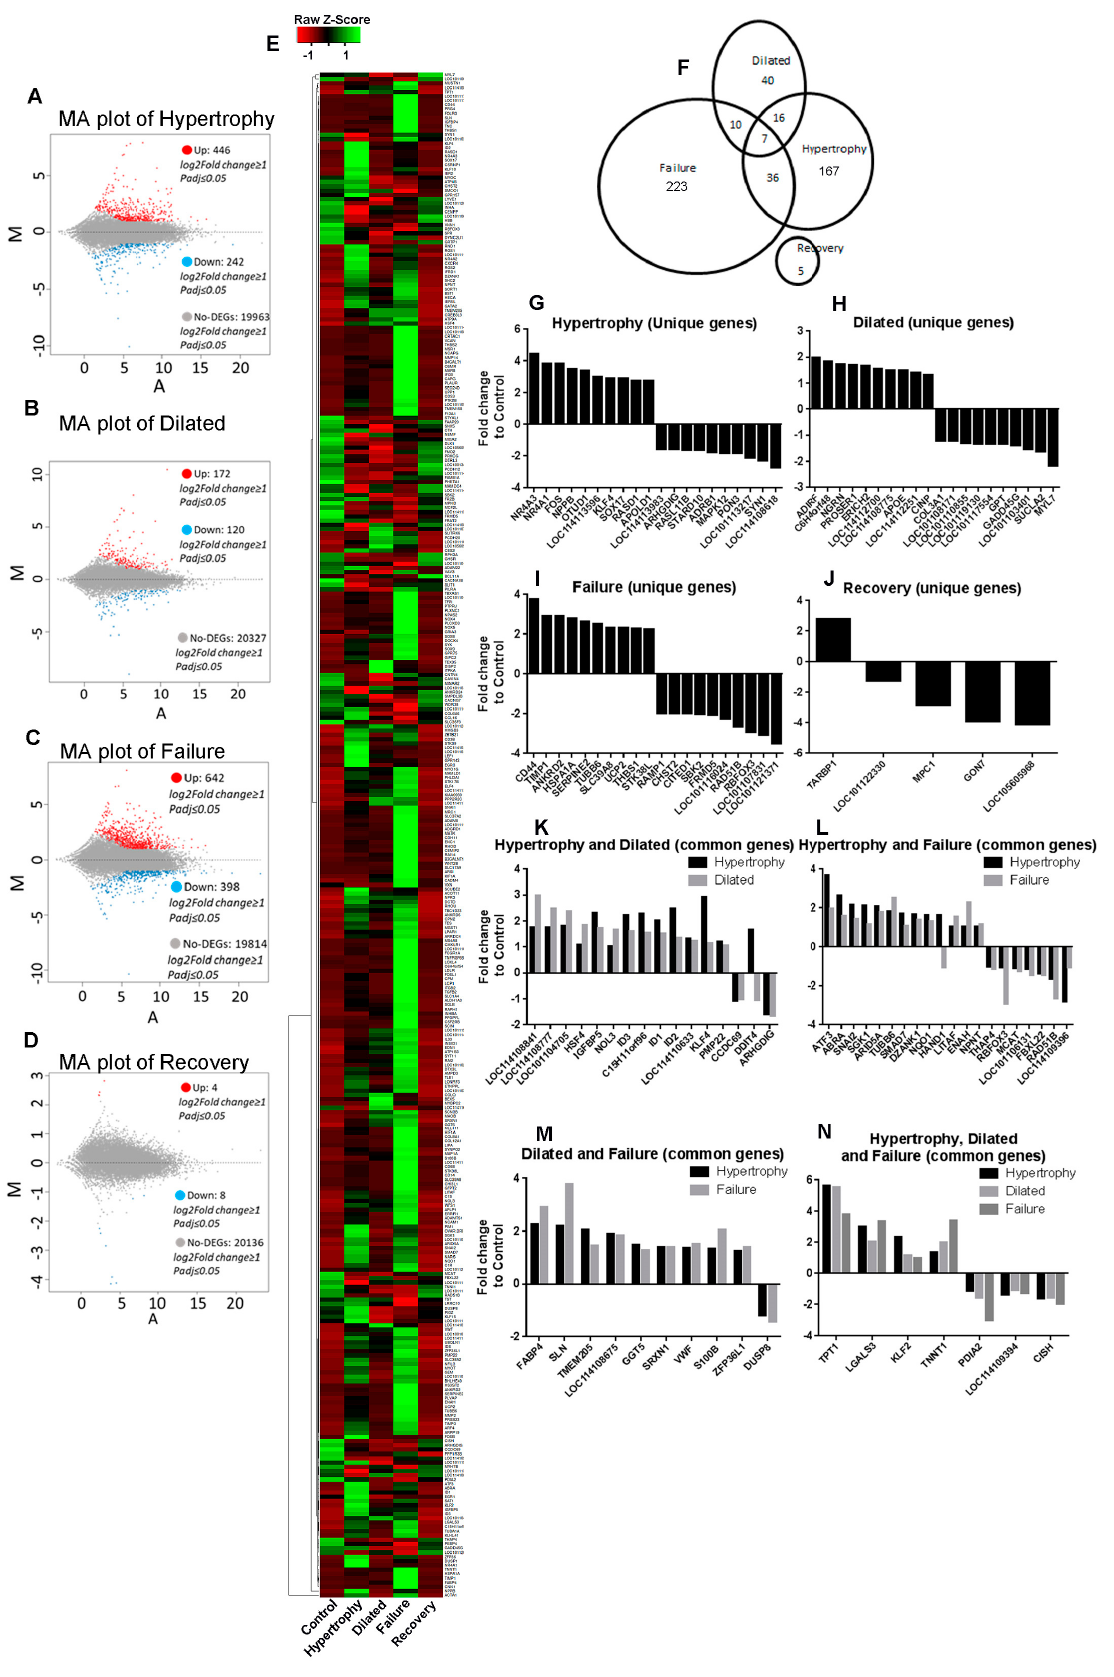
Figure 2. Characteristics of differential gene expression. ( A – D ) The MA plots of the hypertrophy through recovery compared to control show the total expression of genes. The X-axis